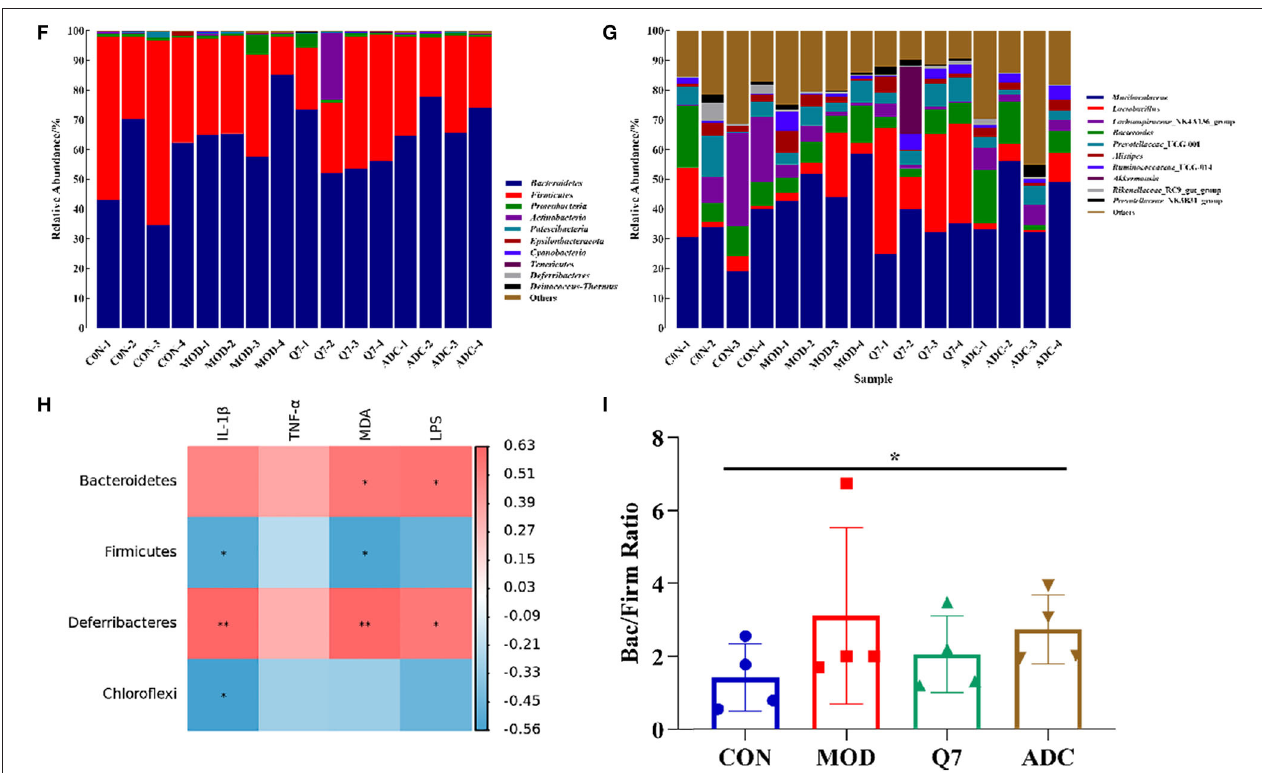
FIGURE 8 | Effects of L. plantarum Q7 on gut microbe of mice. (A) α -diversity indexes calculated with QIIME2 according to ASV/OTU numbers of each group ( P < 0.05). (B,C) Venn diagram of ASV/OTU in the feces. (D) β -diversity evaluated using the weighted UniFrac-based PCA. (E) β -diversity evaluated using the weighted UniFrac-based PCoA. (F) Bar graphs showing the relative abundance of different bacteria at the phylum level. (G) Bar graphs showing the relative abundance of different bacteria at the gene level. (H) Correlation matrix between the microbiota and inflammatory cytokines. (I) Changes of the Bac/Firm Ratio in the different groups ( P <